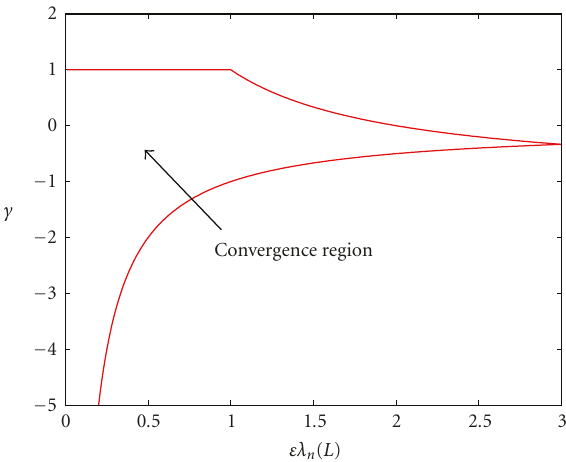
Figure 2: Convergence region for the SO-DCTS algorithm in undirected networks: two-dimensional